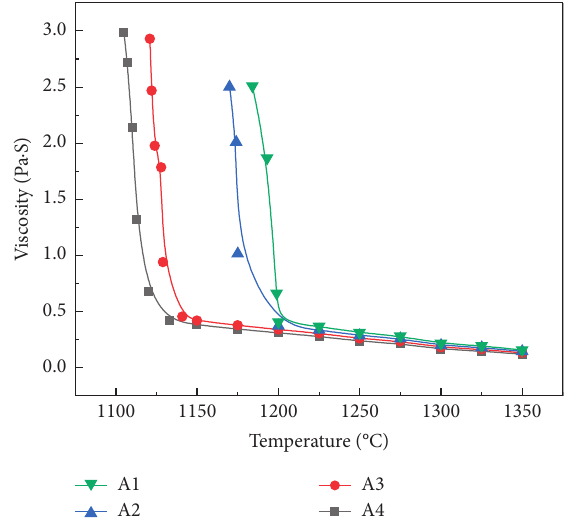
Figure 8: Viscosity of mold fluxes as a function of Li under various temperature conditions.